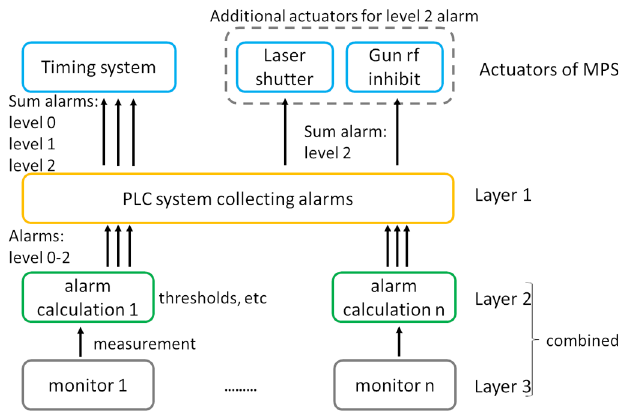
FIG. 1. Schematic principle of the machine protection system (MPS).